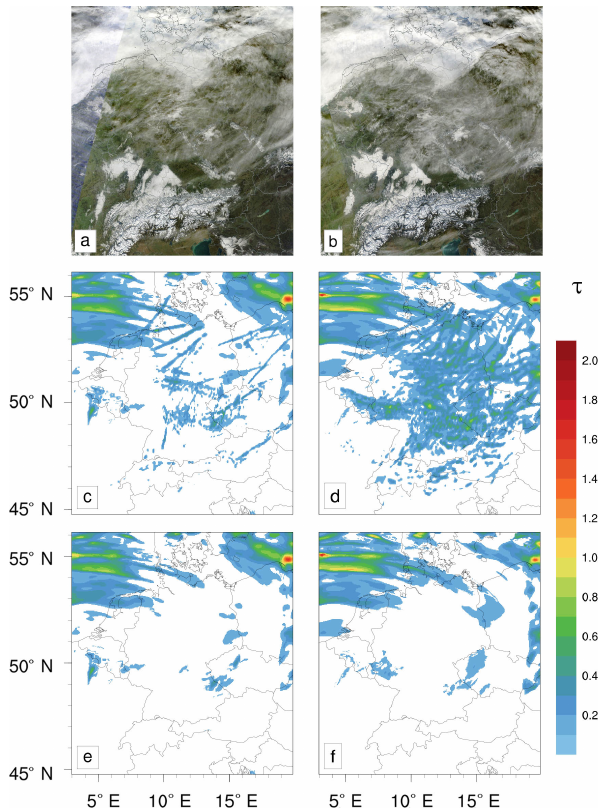
Figure 10. (a, b) Satellite image (MODIS True Color – Corrected Reflectance) (NASA/GSFC/ESDIS, 2018). (c, d) Optical depth at 1 . 115µm of all ice clouds for the aviation simulation. (e, f) Optical depth of all ice clouds for the reference simulation. Left column: 10:00UTC; right column: